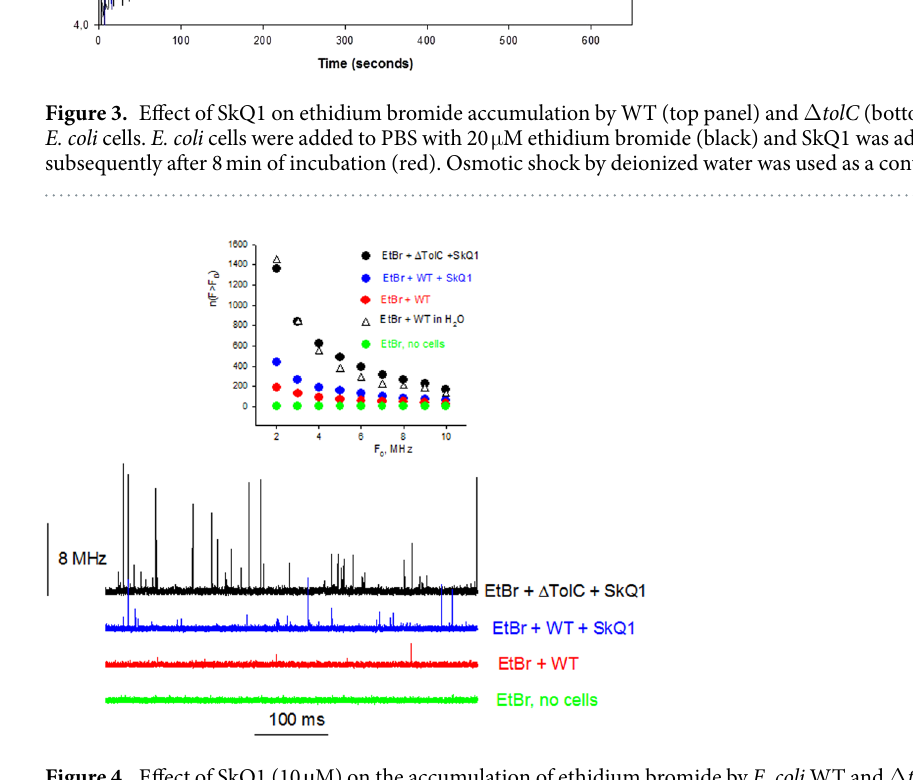
Mycobacterium sp .), differing in cell envelope composition. Our experiments showed that micromolar concen- trations of SkQ1 suppressed the growth of Mycobacterium sp . (Supplementary Fig. S2D), S. aureus (Fig. 1 and Supplementary Fig. S2E), P. phosphoreum (Supplementary Fig. S2F) and R. sphaeroides (Supplementary Fig. S2G). The fact that micromolar concentrations of SkQ1 inhibited both Gram-positive ( B. subtilis, Mycobacterium sp . and S. aureus) and Gram-negative ( P. phosphoreum and R. sphaeroides) bacteria supported our assumption that the cell envelope permeability depended on the operation of membrane transporters rather than on structural features of the permeability barrier.